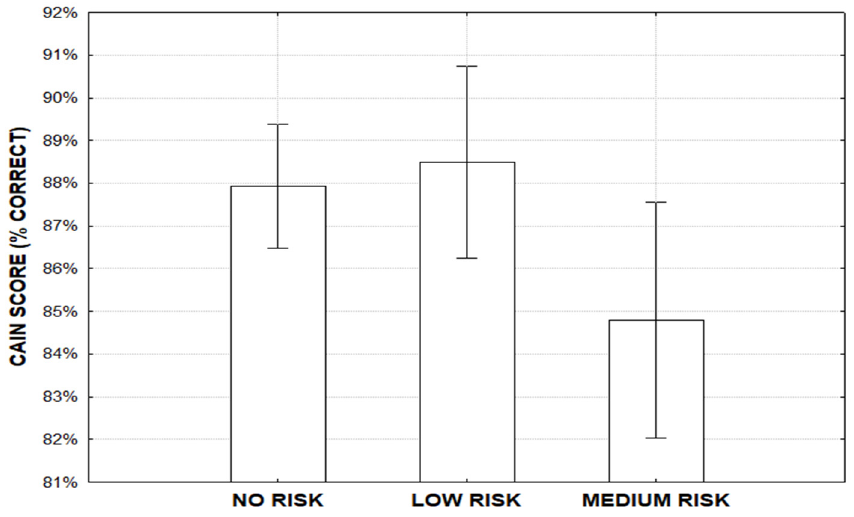
Figure 3. CAIN scores by risk